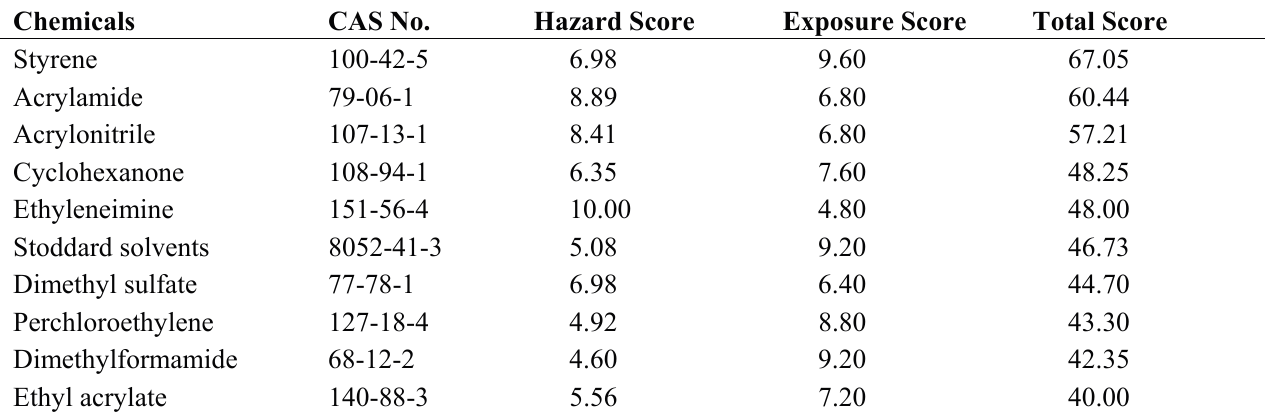
Table 5. Top 10 ranked chemicals used in the algorithm.